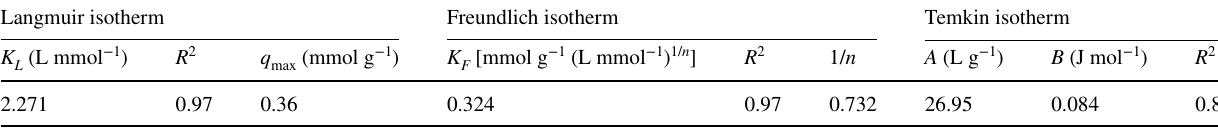
Table 4 Parameters of adsorption isotherms of Pb 2+ on DSB550-3 biochar Langmuir isotherm